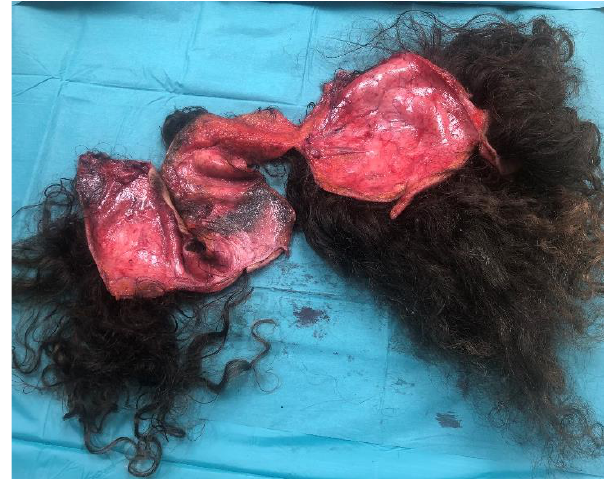
Figure 1. Avulsed scalp.